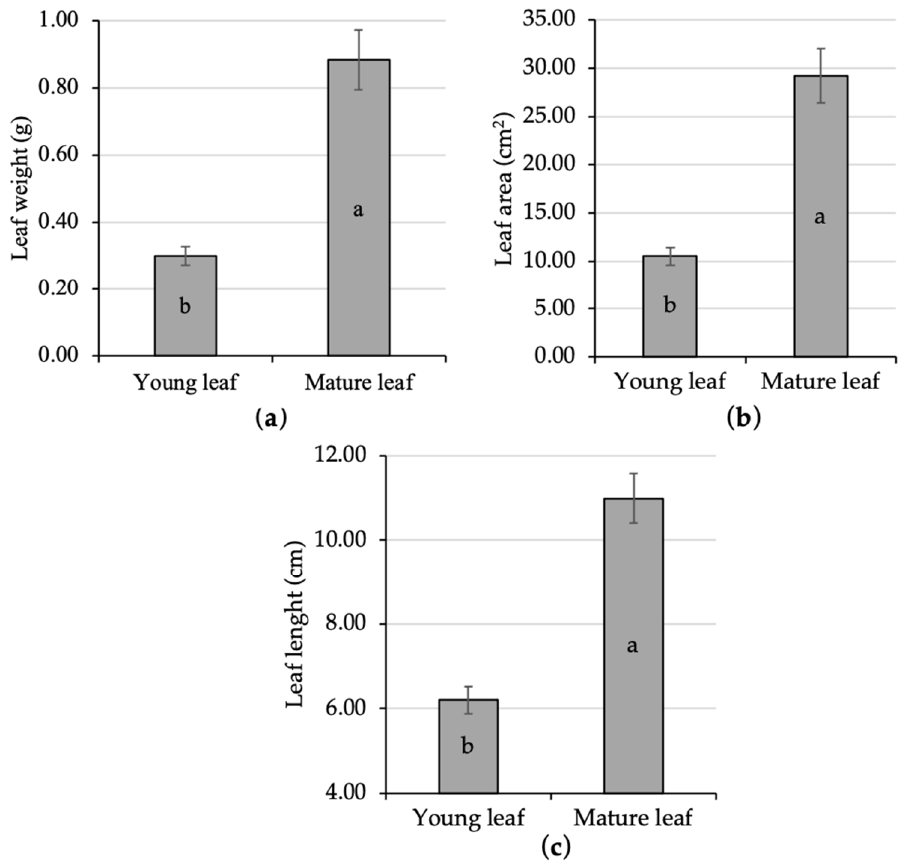
Figure 1. Comparative analysis of the size of young and mature kaffir lime leaf; namely, leaf weight ( a ), leaf area ( b ), and leaf length ( c ). Different letters inside the rectangular bar indicate a significant difference based on the LSD test at α 5%; the error bar represents the standard deviation.